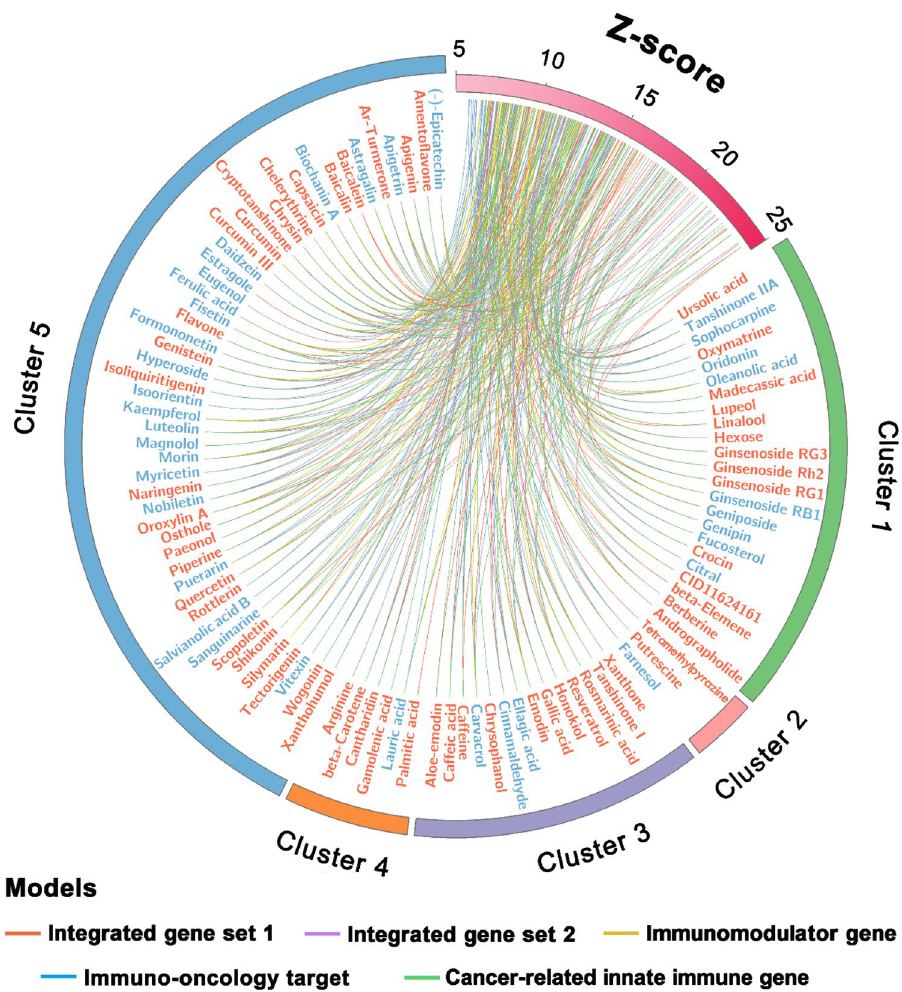
Figure 5. Circos plot exhibiting the 95 predicted natural products (adjusted- P < 0.01) with direct evidence (in red font) or indirect evidence (in blue font). Natural products are grouped by chemical scaffold clustering analysis (Supplementary Fig. S1). The predicted associations from different statistical network models are connected lines in various colors. The full version exhibiting all the 182 predicted natural products (adjusted- P < 0.01) is provided in Supplementary Fig. S2. The circos plots were drawn using Circos (v0.69) 37